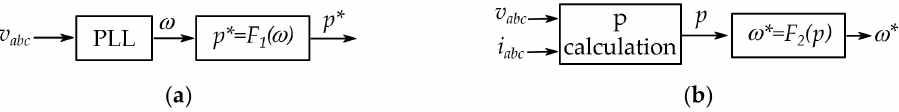
Figure 1. Representative block diagram of the synchronizing method used in inertia emulation (IE) for Battery Energy Storage Systems applications: ( a ) phase-locked loop (PLL)-based and ( b )